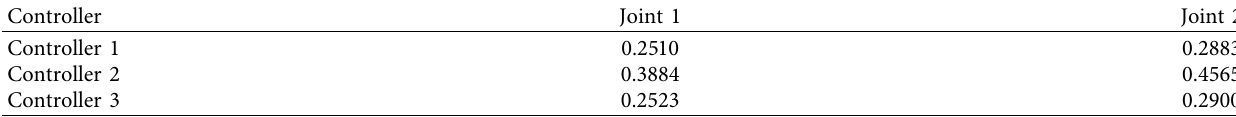
Table 1: Comparison of RMSE (rad) of 3 controllers (0s).